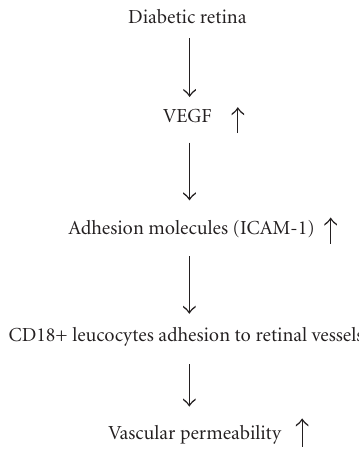
Figure 2: Schematic representation of the molecular mechanism of macular edema. VEGF drives the expression of ICAM-1 in the retinal vessels, which subsequently makes CD18+ leukocytes adher- ent to the retinal vessels. Adhesion of leukocytes to the retinal ves- sels leads to increased vascular leakage, subsequent endothelial cell damage, and capillary